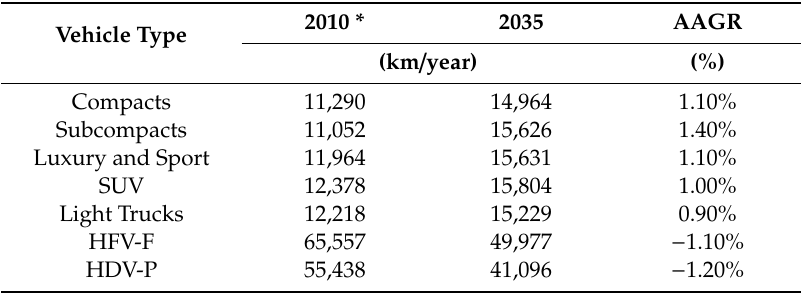
Table 5. Evolution of annual kilometers travelled by vehicle type.